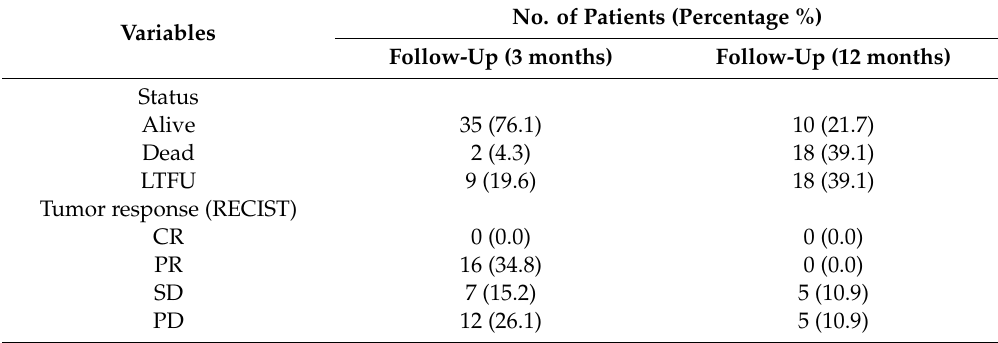
Table 5. Results of follow-up at 3 and 12